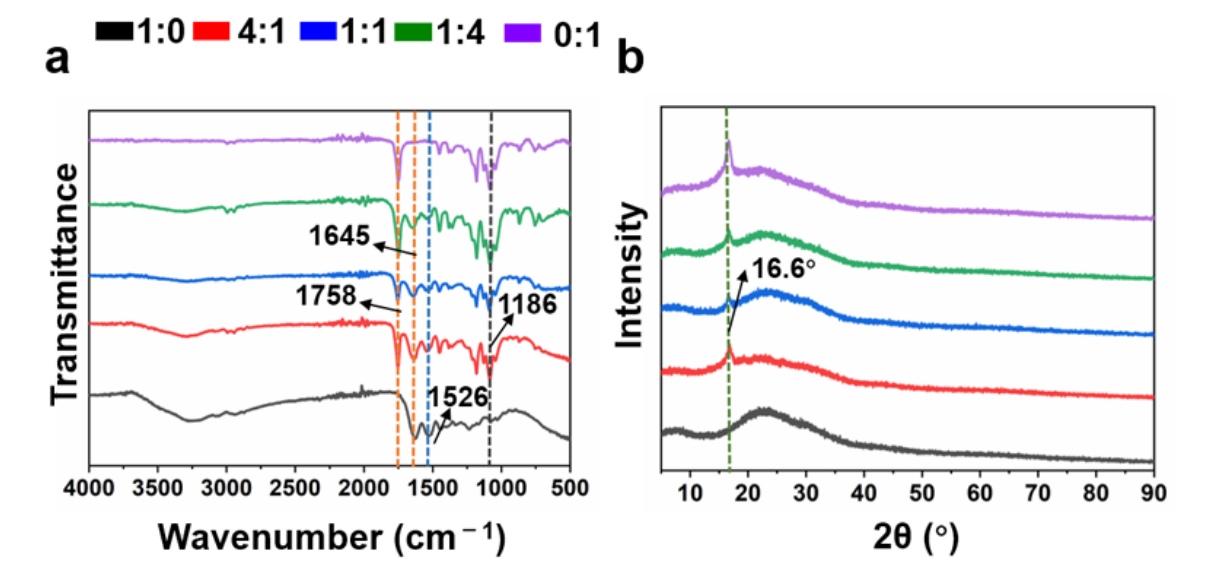
Figure 3. ( a ) The FTIR spectrum and ( b ) XRD spectrum of different crosslinked MeGel/PLLA nanofiber mats (MeGel/PLLA = 1:0, 4:1, 1:1, 1:4, and 0:1). nanofiber mats (MeGel/PLLA = 1:0, 4:1, 1:1, 1:4, and 0:1).